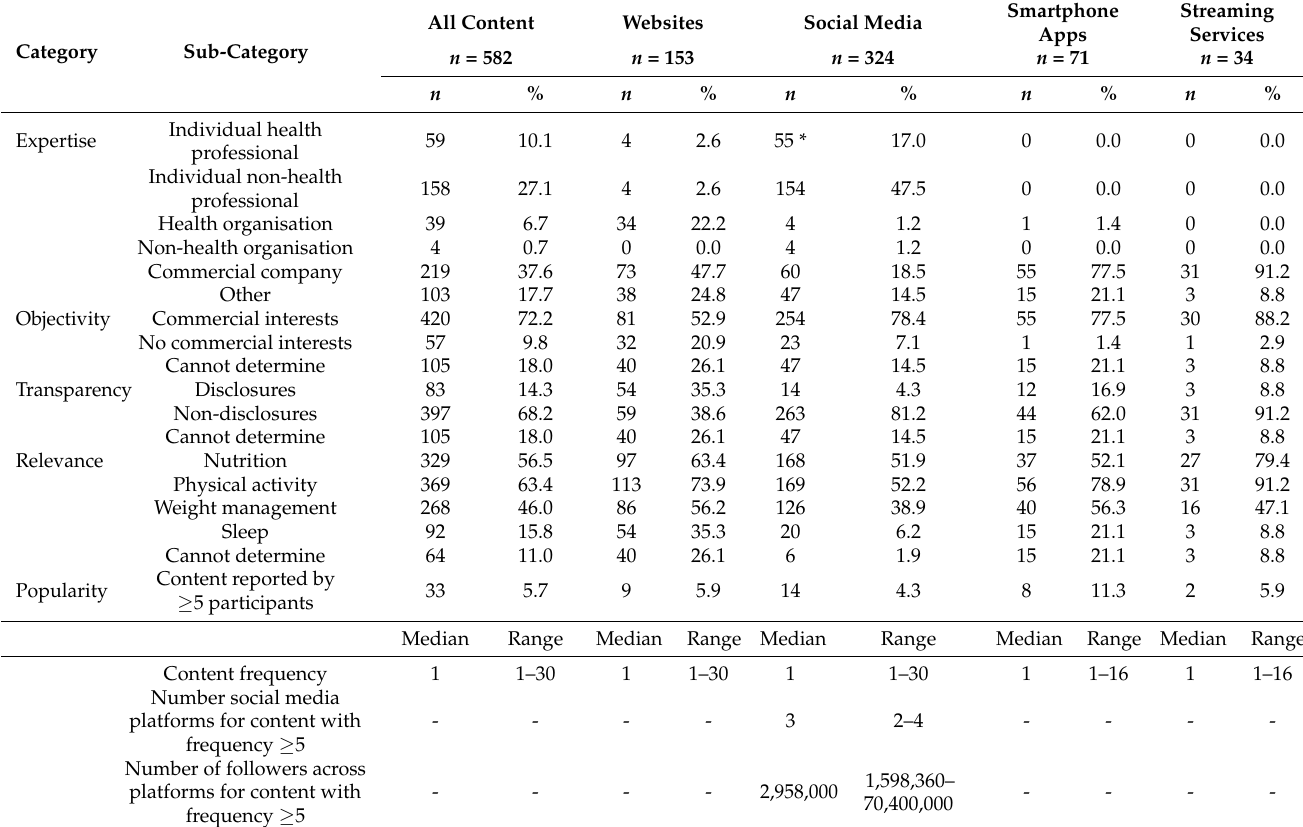
Table 3. Content analysis of popular pages, persons, apps, shows, or documentaries reported by